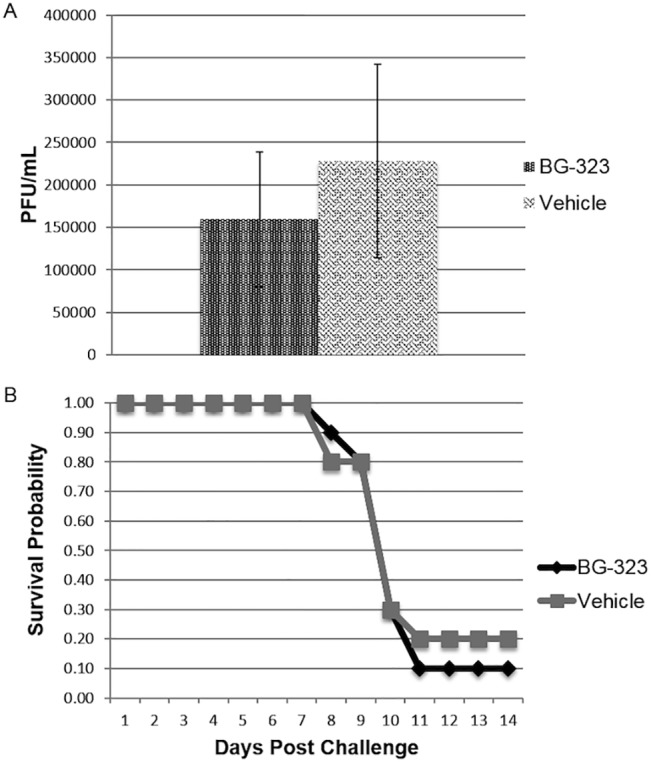
Efficacy of BG-323 in West Nile virus-challenged mice.Mice were challenged with 500 PFU WNV (NY99) via footpad injection then administered 50 mg/kg BG-323 or vehicle by IP inoculation BID for 5 days. Mice were bled on day 3 post challenge and average viral titers were calculated by plaque assay. (A) Average PFU/mL on day three post-challenge are presented for BG-323-challenged and control animals. (B) Clinical scores were assigned animals up to 14 days-post-challenge and Kaplan-Meier estimates of survival probability were calculated.